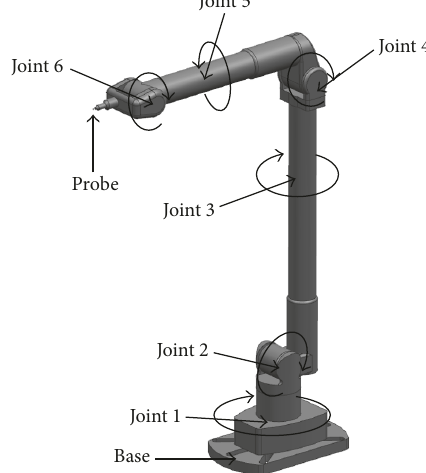
Figure 1: The structure of the